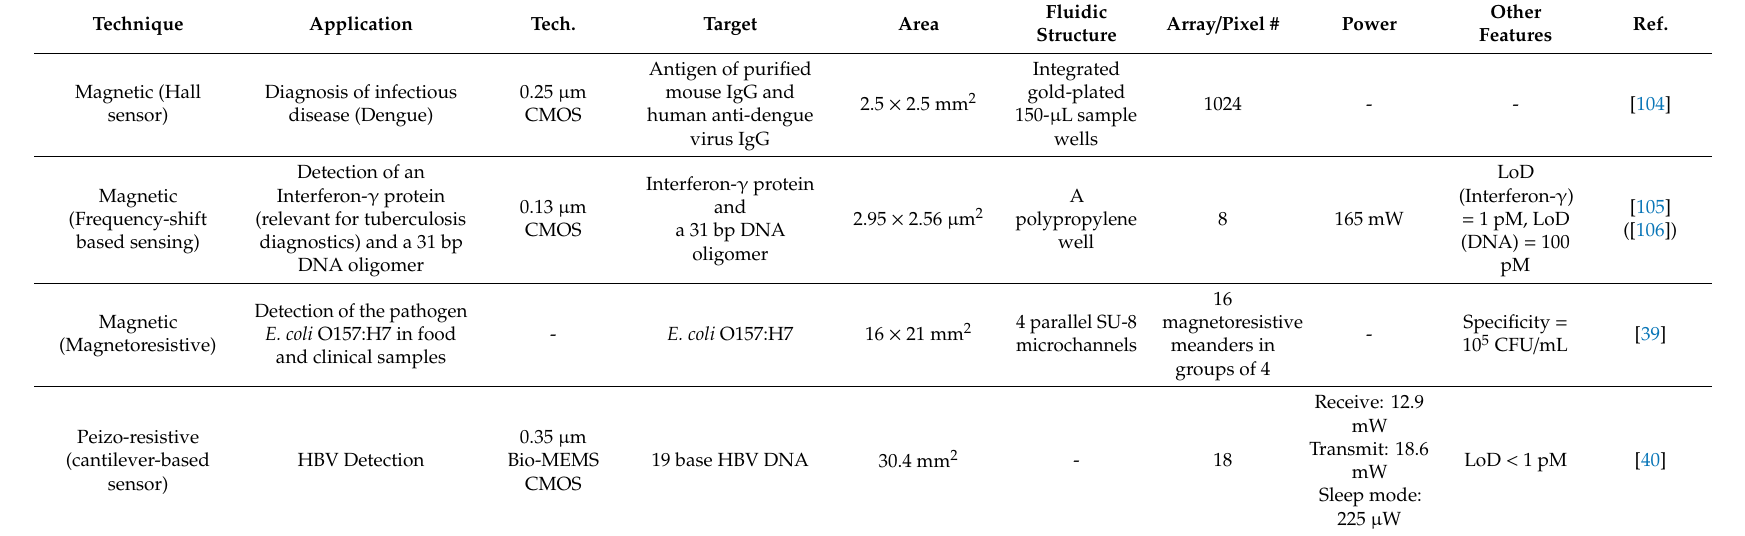
Table 5. Magnetic, mechanical and other CMOS-based devices reported for the diagnosis of various infectious